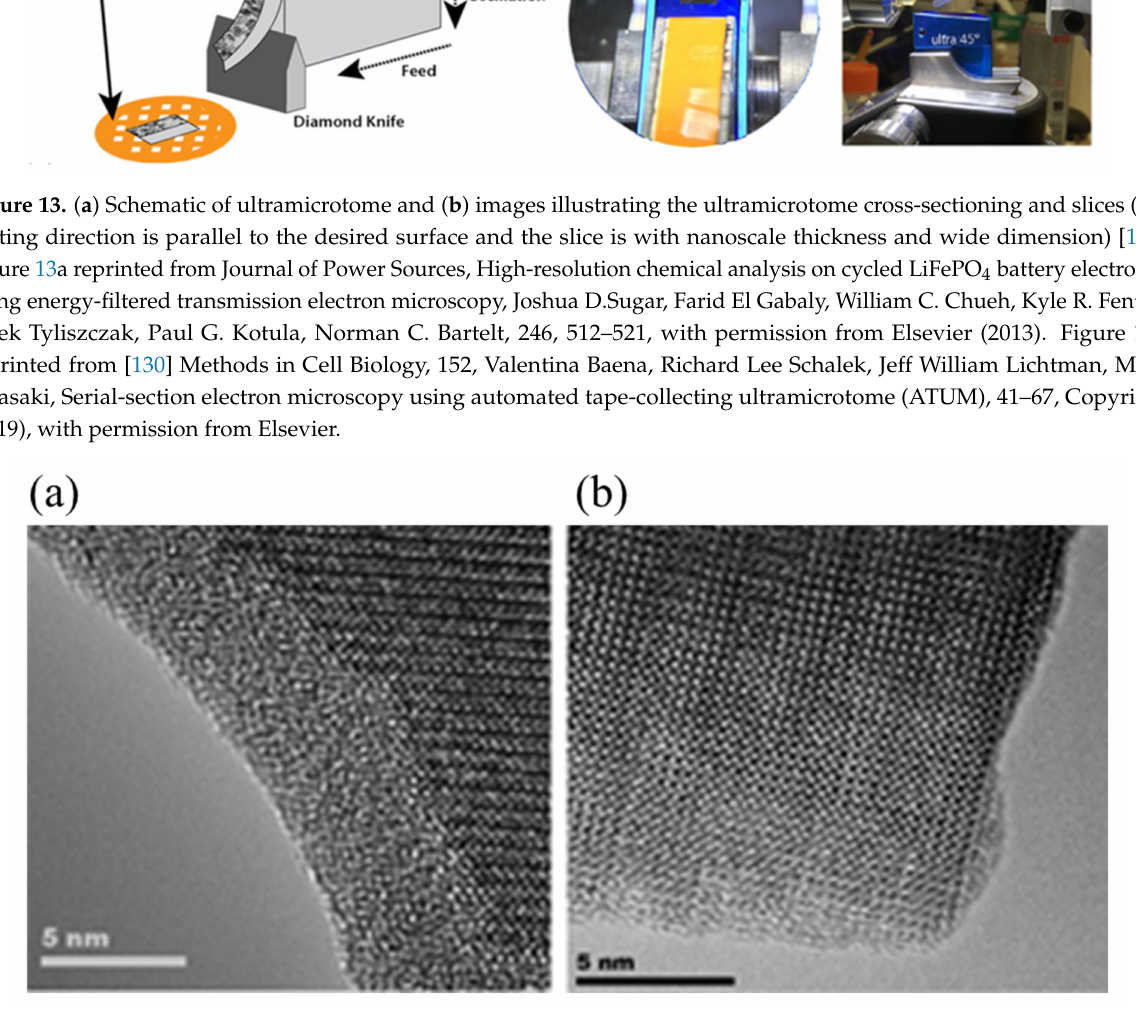
Figure 14. HRTEM images of La 0.29 Sr 0.7 Al 0.65 Ta 0.35 O 3 substrate with nickelate and aluminate heterostructures below the surface. ( a ) specimen polished with 5 kV FIB. ( b ) specimen went through nanomilling at 500 V as a final treatment step. The lattice fringes are clear even at sample edge [134]. Reprinted from Ultramicroscopy, Practical aspects of the use of the X 2 holder for HRTEM-quality TEM sample preparation by FIB, Willem van Mierlo, Dorin Geiger, Alan Robins, Matthias Stumpf, Mary Louise Ray, Paul Fischione, Ute Kaiser, 147, 149–155, Copyright (2014), with permission from